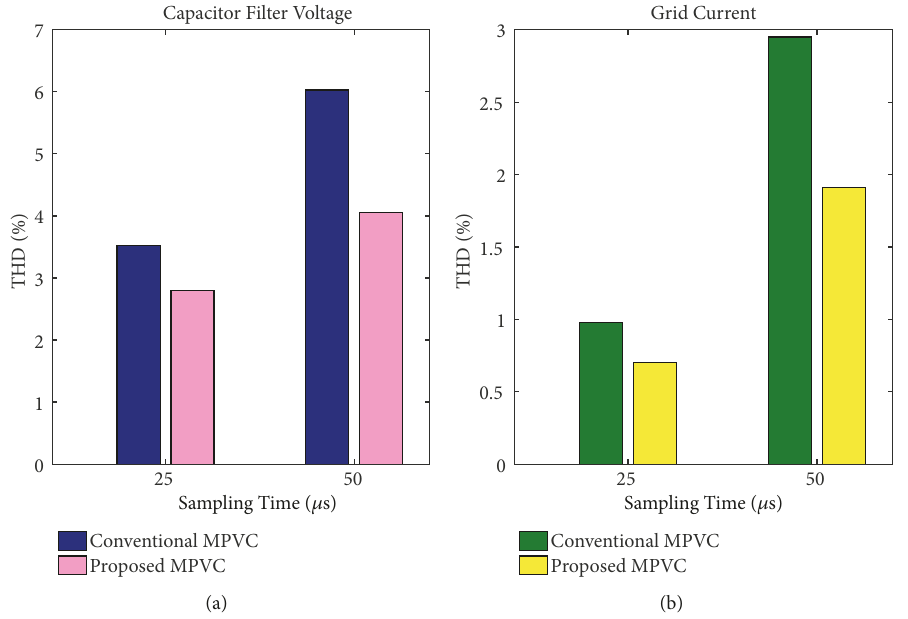
Figure 10: Comparative simulation results of THD for the conventional and proposed MPVC. (a) Capacitor filter voltage. (b) Grid current.